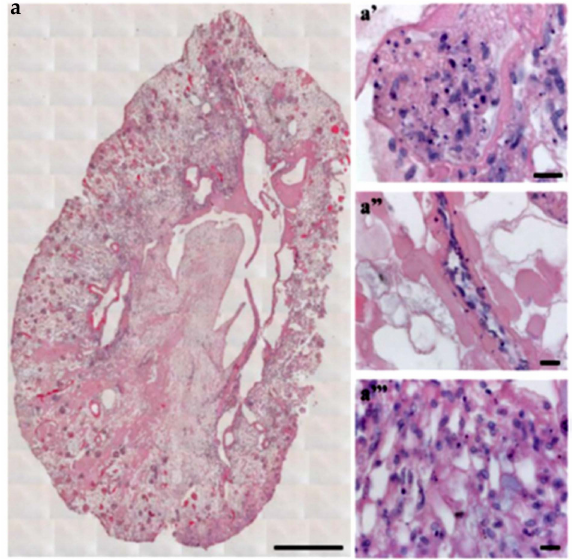
Figure 3. Decellularized kidney scaffold obtained from adult male rat reseeded with iPSC-derived endothelial cells. ( a ) Cross-section of repopulated kidney showing homogeneous distribution of iPSC-derived ECs into glomeruli and vascular structures. Scale bar 1 cm. ( a (cid:48) – a (cid:48)(cid:48)(cid:48) ) Images showing iPSC-derived ECs localization into glomerulus ( a (cid:48) ), vascular network ( a (cid:48)(cid:48) ), and peritubular capillaries ( a (cid:48)(cid:48)(cid:48) ). Scale bar 20 µ m. (Reproduced with permission from Springer Nature under Creative Commons License, adapted from reference